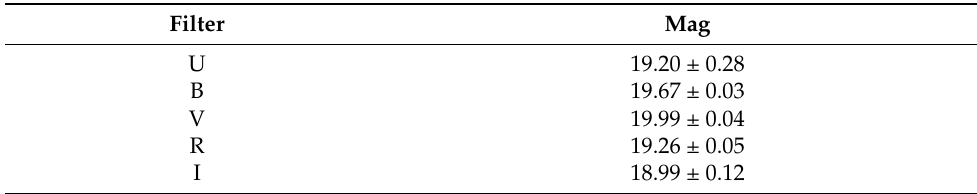
Table 3. New estimates of the (uncorrected for extinction) central star’s UBVRI Johnson magnitudes as measured from our FORS2 imaging